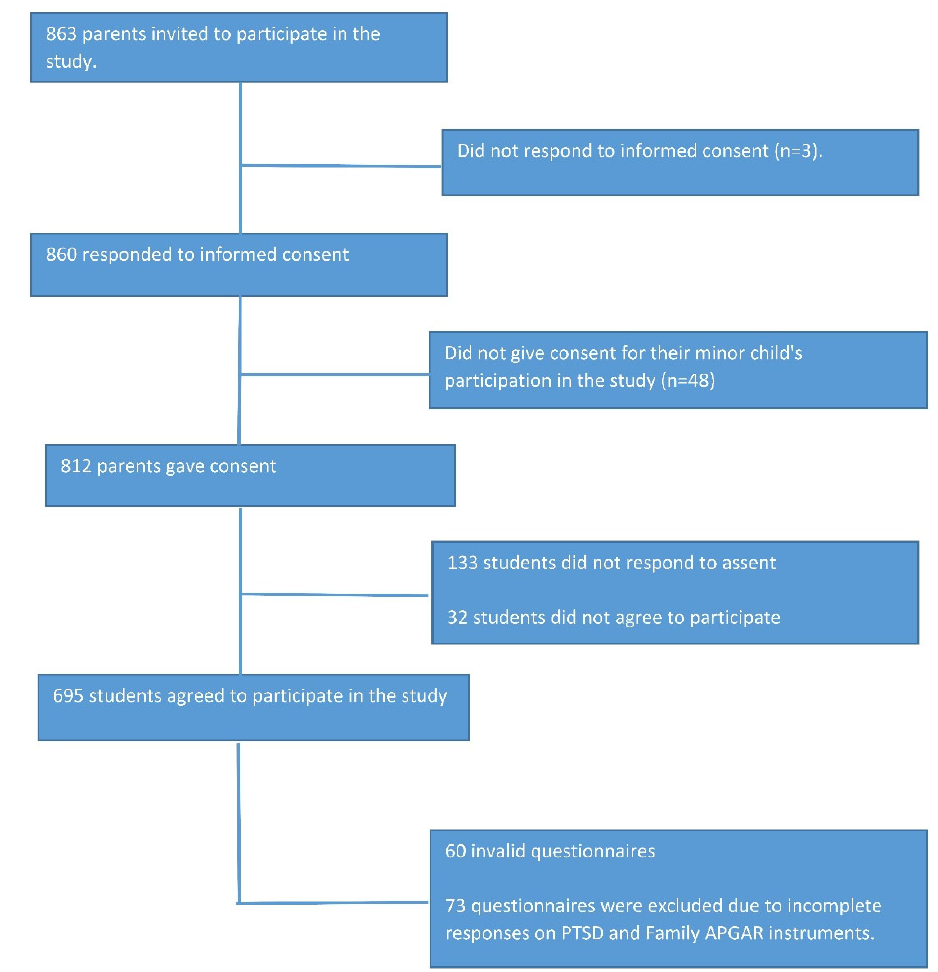
Figure 1. Flowchart of participant selection.